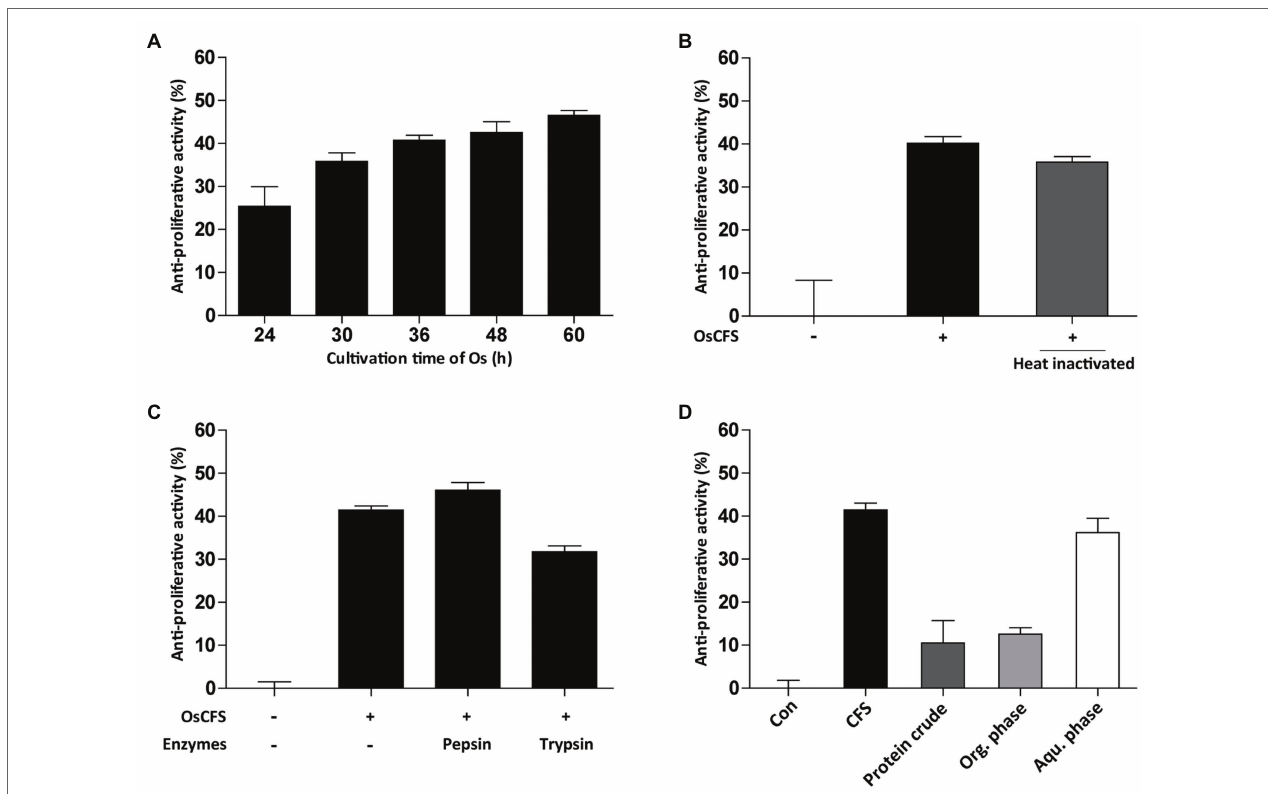
FIGURE 3 | Characterization of active substances from Odoribacter splanchnicus cell-free supernatant (OsCFS). Data are expressed as mean ± standard error of three independent experiments. (A) The production level of active substances depending on cultivation time of O. splanchnicus . (B,C) The effect of heat-inactivation and proteinase treatment on anti-proliferative activity. (D) The anti-proliferative activity of protein crude (precipitated proteins by ammonium sulfate), organic phase (Org. phase), and aqueous phase (Aqu. Phase) of the EtOAc